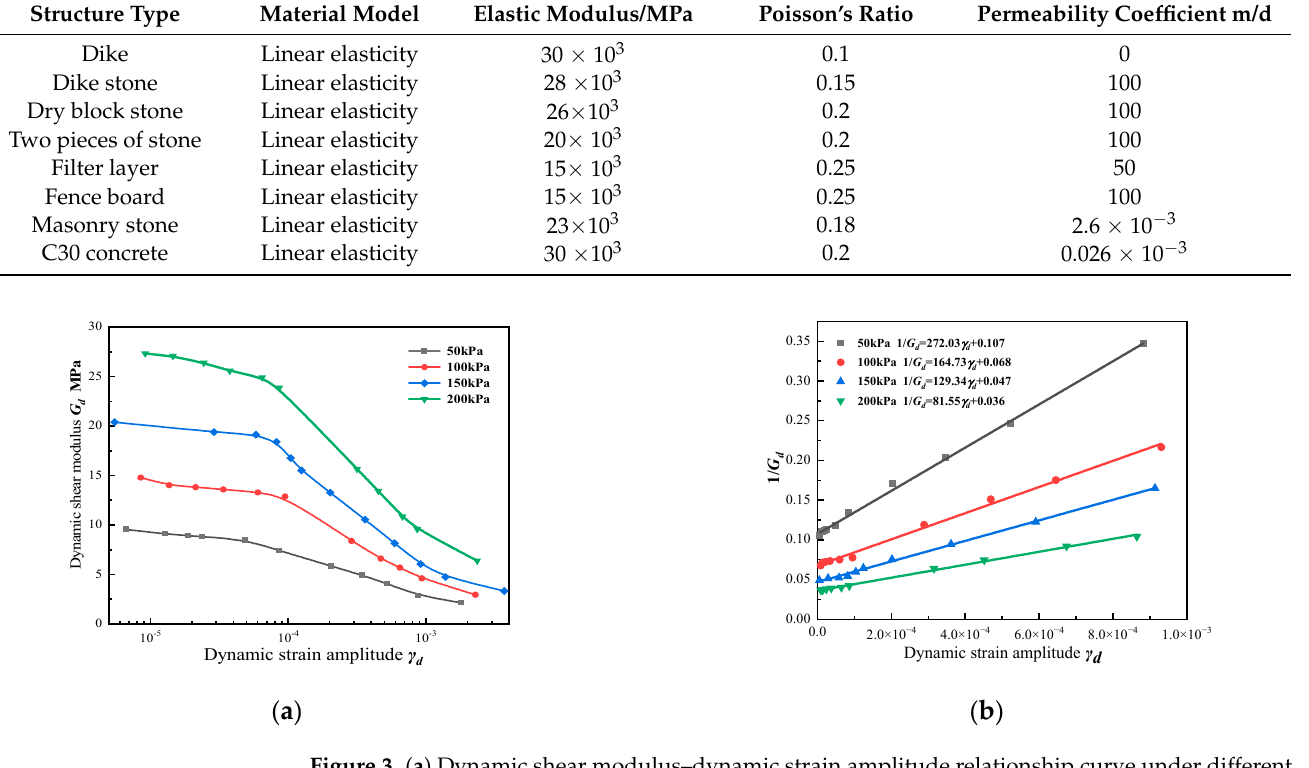
Table 1. Dike material parameters.